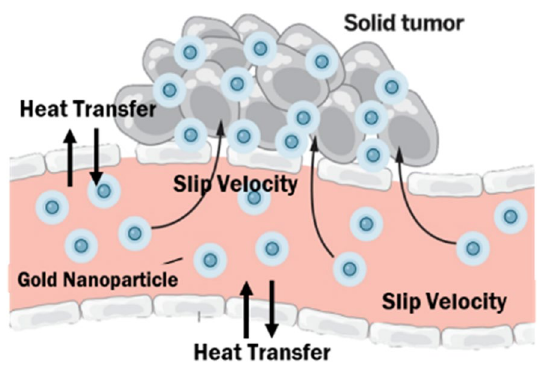
Figure 2. Real application diagram 77